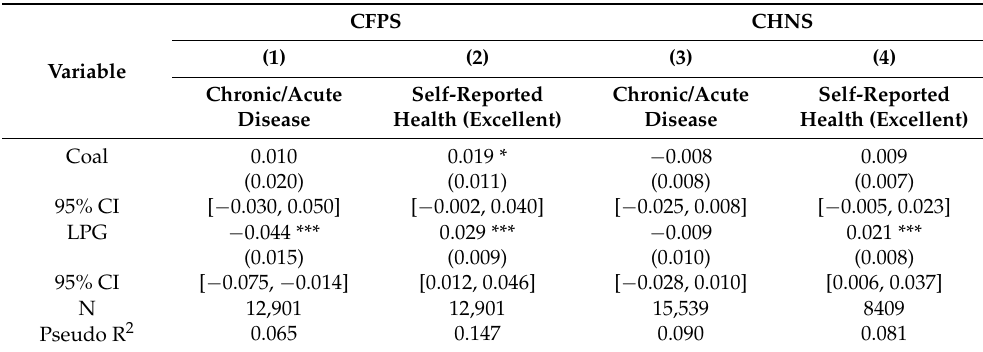
Table 3. (Ordered) probit estimates for the effect of household cooking fuels on women’s health in rural area: CFPS 2010–2012 and CHNS 1991–2009.